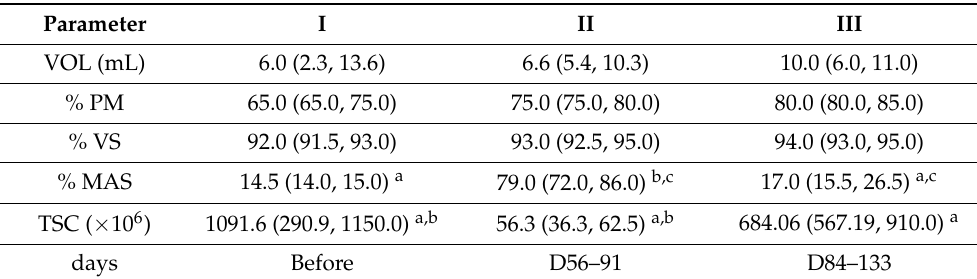
Table 2. Comparative results of pre-treatment semen analysis (I), of the first evaluable ejaculates after implant removal (II) and first normospermic ejaculates (III); results of TG ( n = 5) are given as median (Q1,